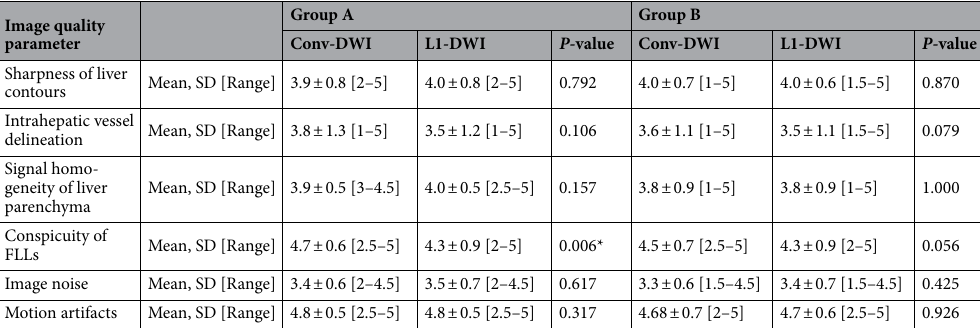
Table 3. Qualitative analysis results of the image quality from conv-DWI and L1-DWI in both patient groups. Mean scores of image quality parameters ± SD and range. conv-DWI Single-shot EPI-based DWI with parallel imaging reconstruction, L1-DWI Single-shot EPI-based DWI with L1-regularized iterative reconstruction, SD Standard deviation. Significant p -values are highlighted with an asterisk. P -values are from Wilcoxon signed-rank test.